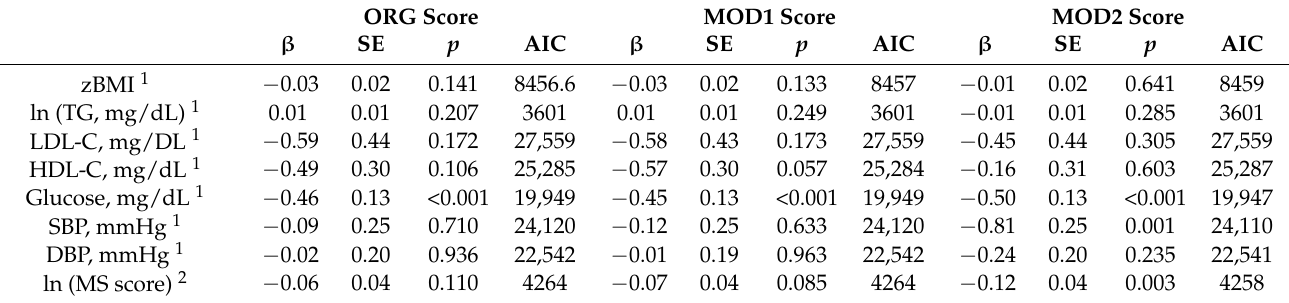
Table 5. Regression analysis of the effect of 10-point scores on cardiometabolic